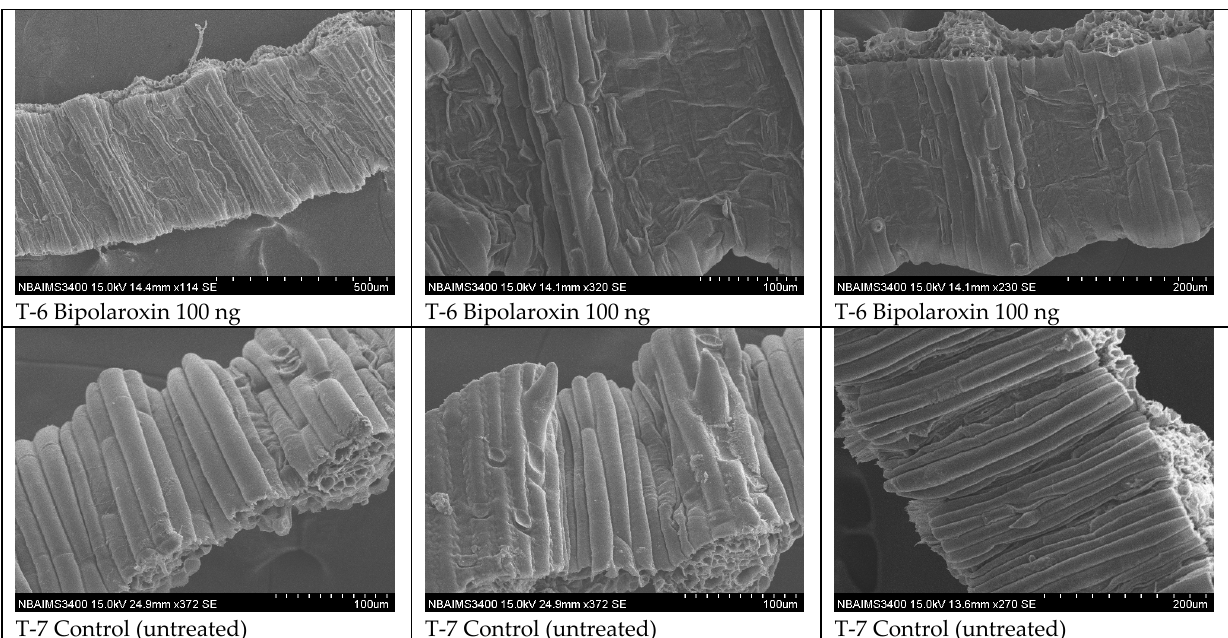
Figure 15. Effects of different treatments on cell wall integrity and tissue disintegration in the susceptible and resistant lines/cultivars of wheat at 30 days of under pathogen inoculation and infiltration of partially purified toxin obtained from B. sorokiniana as well as chemically synthesized Bipolaroxin.